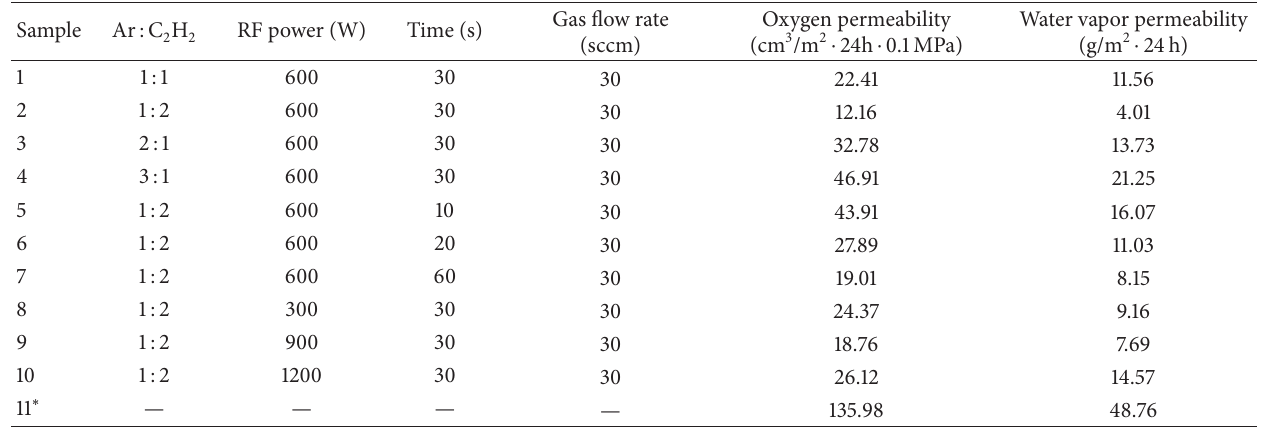
Table 3: Barrier properties under different deposition process.